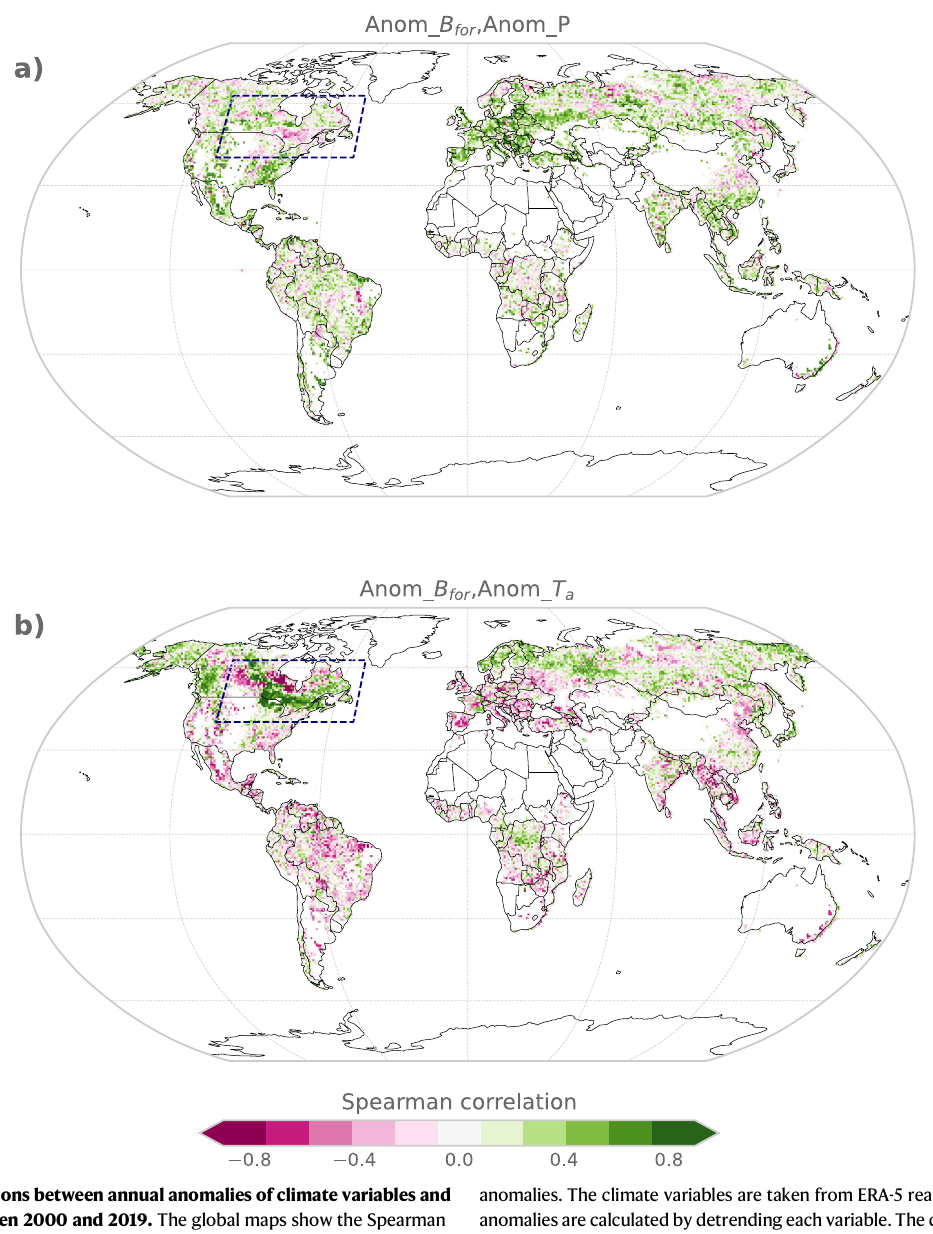
anomalies. The climate variables are taken from ERA-5 reanalysis data. The anomaliesarecalculatedbydetrendingeachvariable.Thedarkblueframedenotes parts of the North American boreal forest, where we fi nd a high (>0.7) positive correlation between air temperature anomalies and biomass carbon